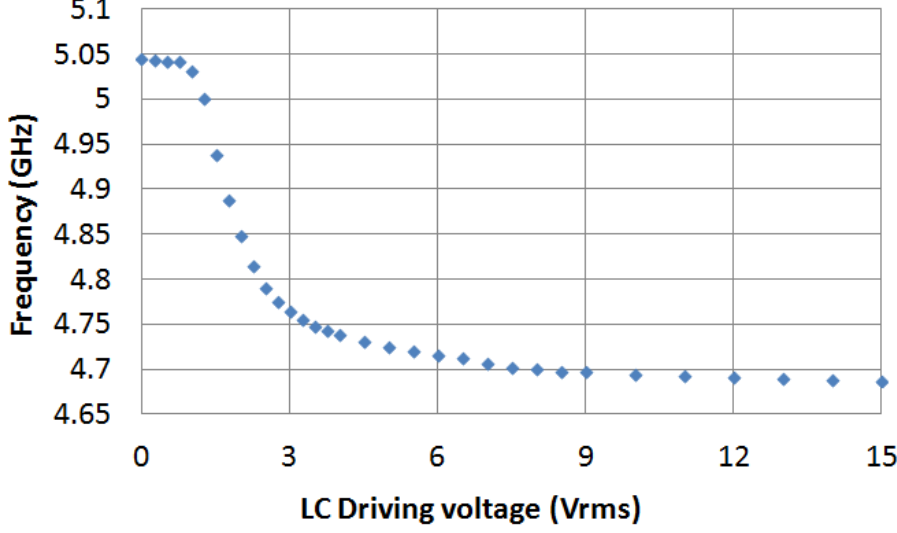
Figure 7. Tunability of the filter central frequency as a function of the LC driving voltage.